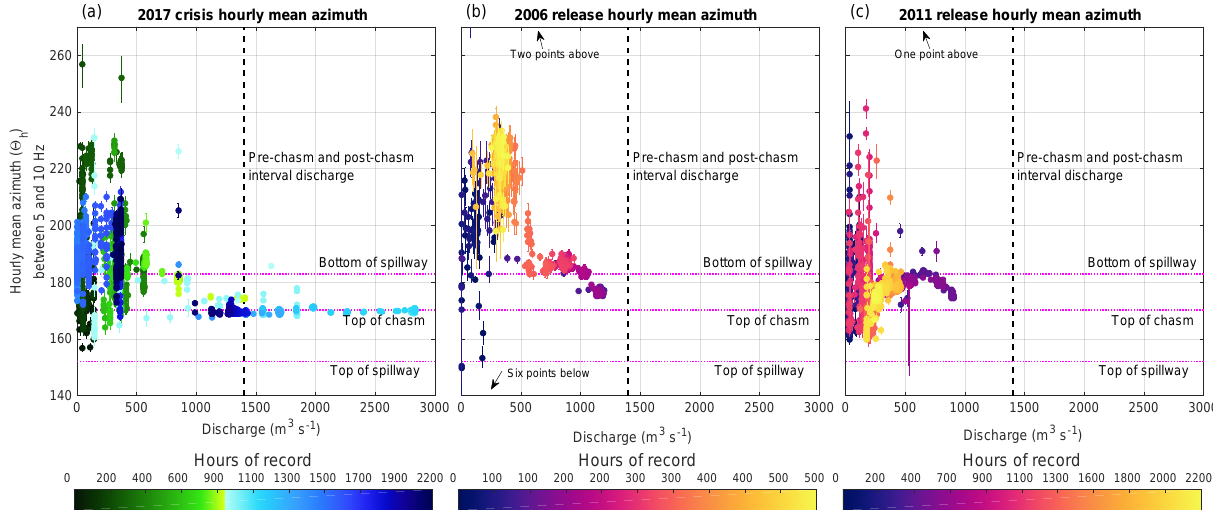
Figure 8. In the 5–10Hz band, hourly mean azimuth ( (cid:50) H ) is displayed in panels (a–c) , with 95% error bars. The mean azimuth is highly variable for discharge less than 500m 3 s − 1 for the flood control releases in 2017 (a) , 2006 (b) , and 2011 (c) . In panel (a) , during the “Pre- chasm” time interval shaded green, the mean horizontal azimuth values point to the bottom of the flood control spillway (183 ◦ , Fig. 1c). After the high releases have formed a chasm that starts in the middle of the flood control spillway, the azimuths consistently point to the channel midpoint. The “Post-chasm” azimuth when discharge is approximately 1400m 3 s − 1 is noticeably distinct from the “Pre-chasm” flows around 1400m 3 s − 1 . During times when the channel is undamaged (b, c) , the mean azimuth is sensitive to changes in discharge as turbulence develops in the middle of the flood control spillway. Due to the 180 ◦ indeterminacy, (cid:50) H shown in this figure is constrained between 90 and 270 ◦ , the direction of the outflow channel.